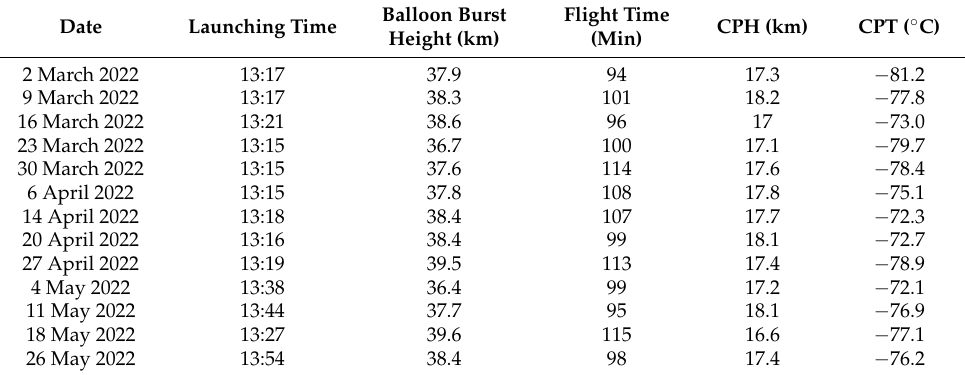
Table 1. Ozonesonde launching details (launching date and time) along with balloon bust height, flight time, CPH (cold point troposphere), and CPT (cold point troposphere temperature) observed in spring 2022 at Shaowu